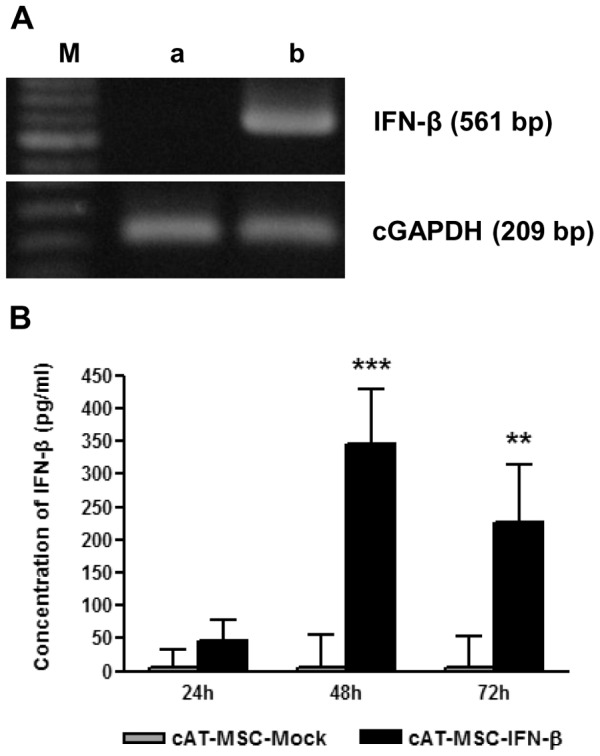
Confirmation of IFN-β expression in cAT-MSC-IFN-β.(A) RT-PCR analysis of canine IFN-β mRNA expression in cAT-MSC-IFN-β compared with cAT-MSC-Mock. The expressions of canine IFN-β and GAPDH (cGAPDH) were detected by reverse transcriptase (RT)-PCR, and GAPDH was employed as an internal control. M, 100-bp DNA size marker; a, cAT-MSC-Mock (empty vector transducted cAT-MSC); b, cAT-MSC-IFN-β. (B) Canine interferon-β concentration (pg/mL as mean +SD) by ELISA in conditioned media harvested after 24, 48 and 72 hours in cAT-MSC-IFN-β compared with cAT-MSC-Mock cells; statistically significant variation between the two cell types at ** p<0.01 or *** p<0.001.